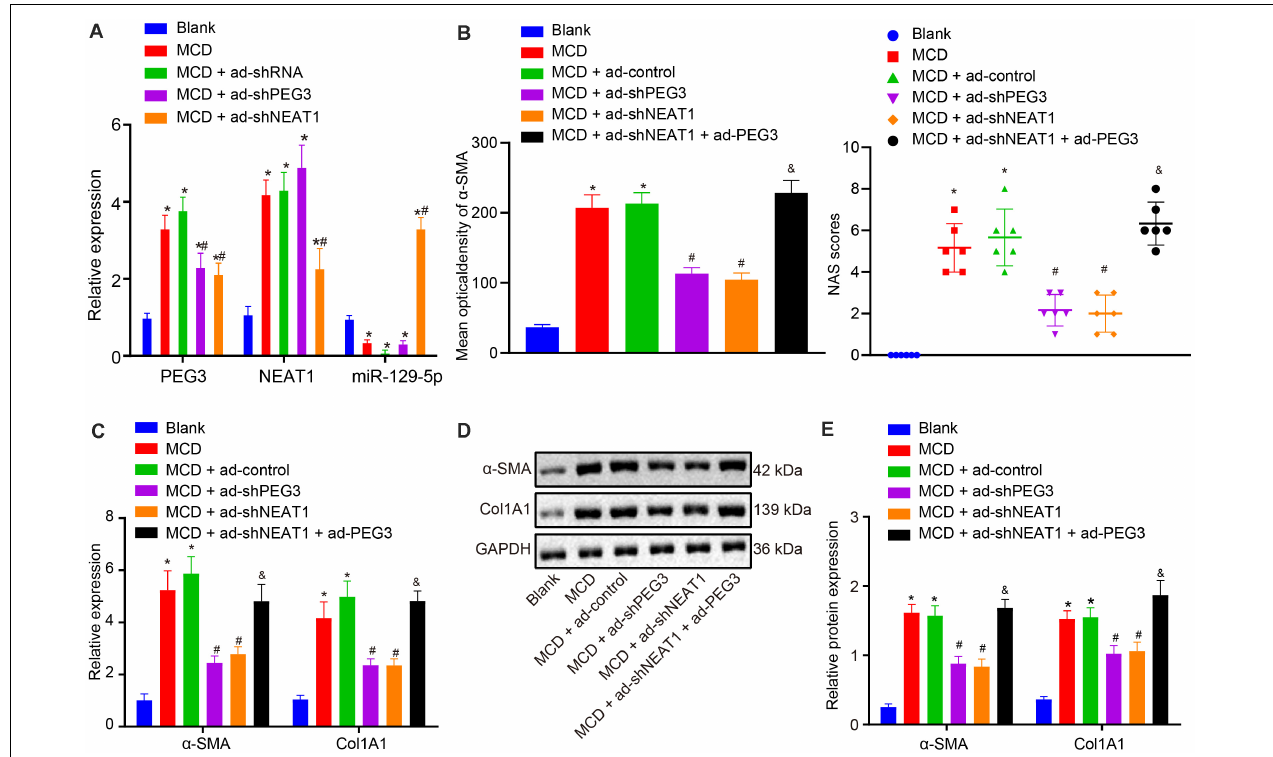
FIGURE 9 | NEAT1 expression has a positive correlation with the effects of PEG3 in NASH mice. (A) Relative expression of PEG3, NEAT1, and miR-129-5p determined by RT-qPCR. (B) Pathological changes of liver tissue in mice on normal diet and the 5-week MCD diet detected by Masson staining ( × 200) (the upper diagram) and HE staining ( × 200) (the lower diagram). (C) Relative expression of α -SMA and Col1A1 determined by RT-qPCR. (D,E) Relative expression of α -SMA and Col1A1 normalized to GAPDH determined by western blot analysis. * p < 0.05 vs. the blank group (mice on normal diet). # p < 0.05 vs. the MCD group (mice on MCD diet alone). & p < 0.05 vs. the MCD + ad-shNEAT1 group (mice on MCD diet and injected with ad-shNEAT1). All data were measurement data and expressed as mean ± standard deviation. One-way analysis of variance was used for data comparison among multiple groups. The experiment was independently repeated three times. N = 6 mice per